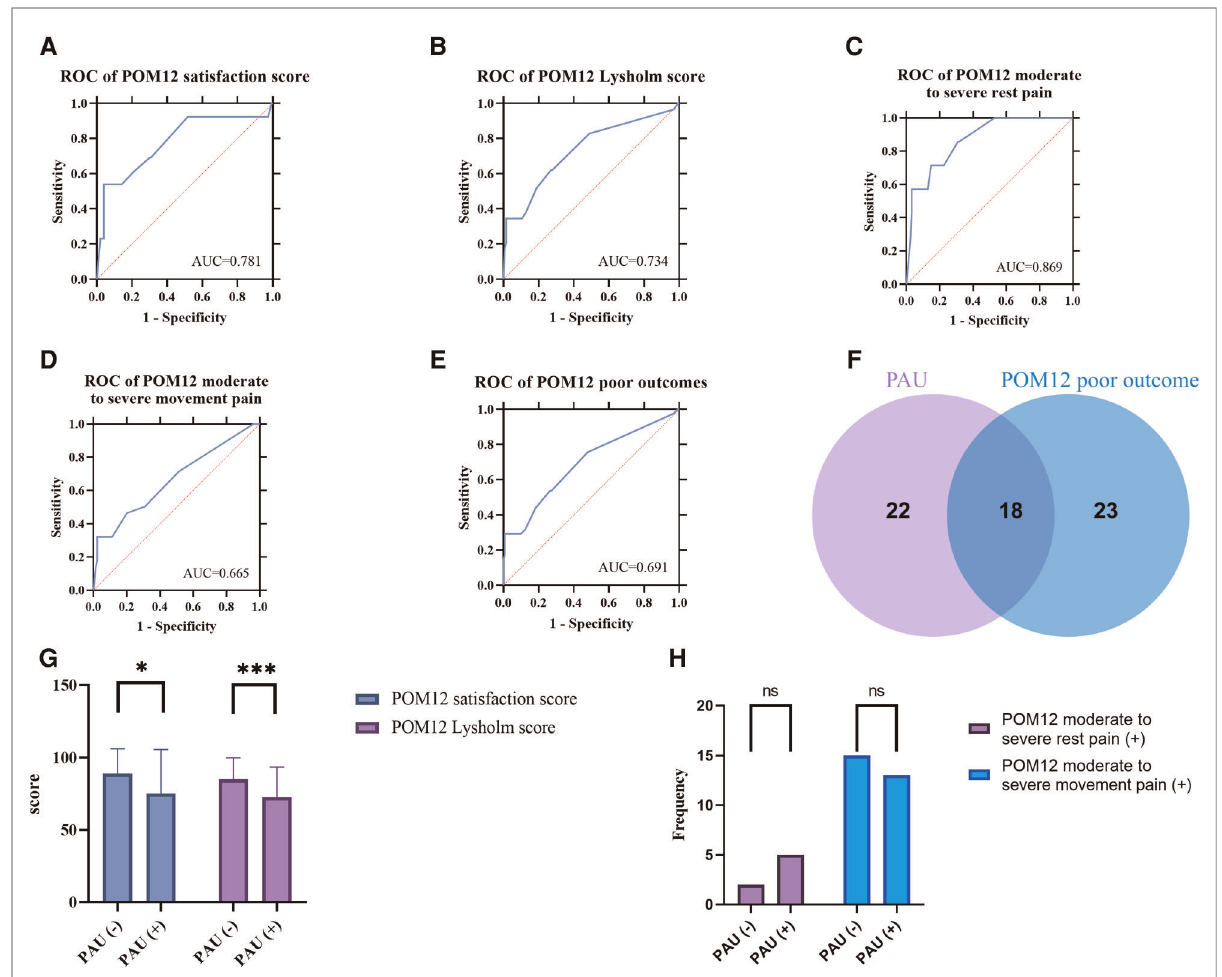
FIGURE 3 ( A – E ) ROC curve of DAU for different POM12 poor outcomes. ( F ) Venn diagram of PAU and POM12 poor outcome. ( G ) POM12 satisfaction score and POM12 Lysholm score of cases with or without PAU. ( H ) Frequency distribution histogram of POM moderate to severe